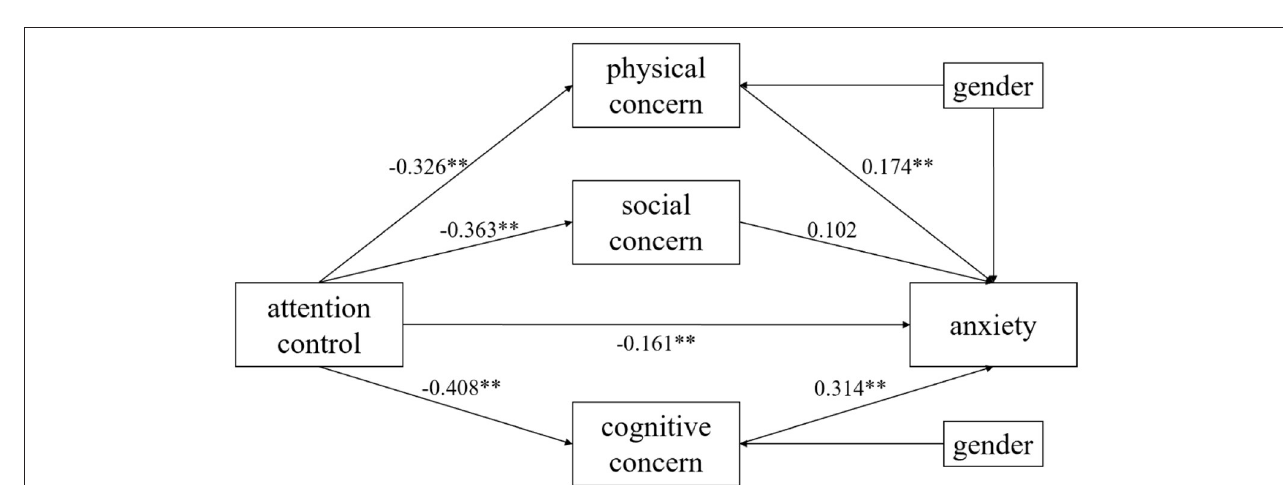
FIGURE 3 | Multiple mediation model (physical, social, and cognitive concerns as mediating variables). ** p < 0.01.